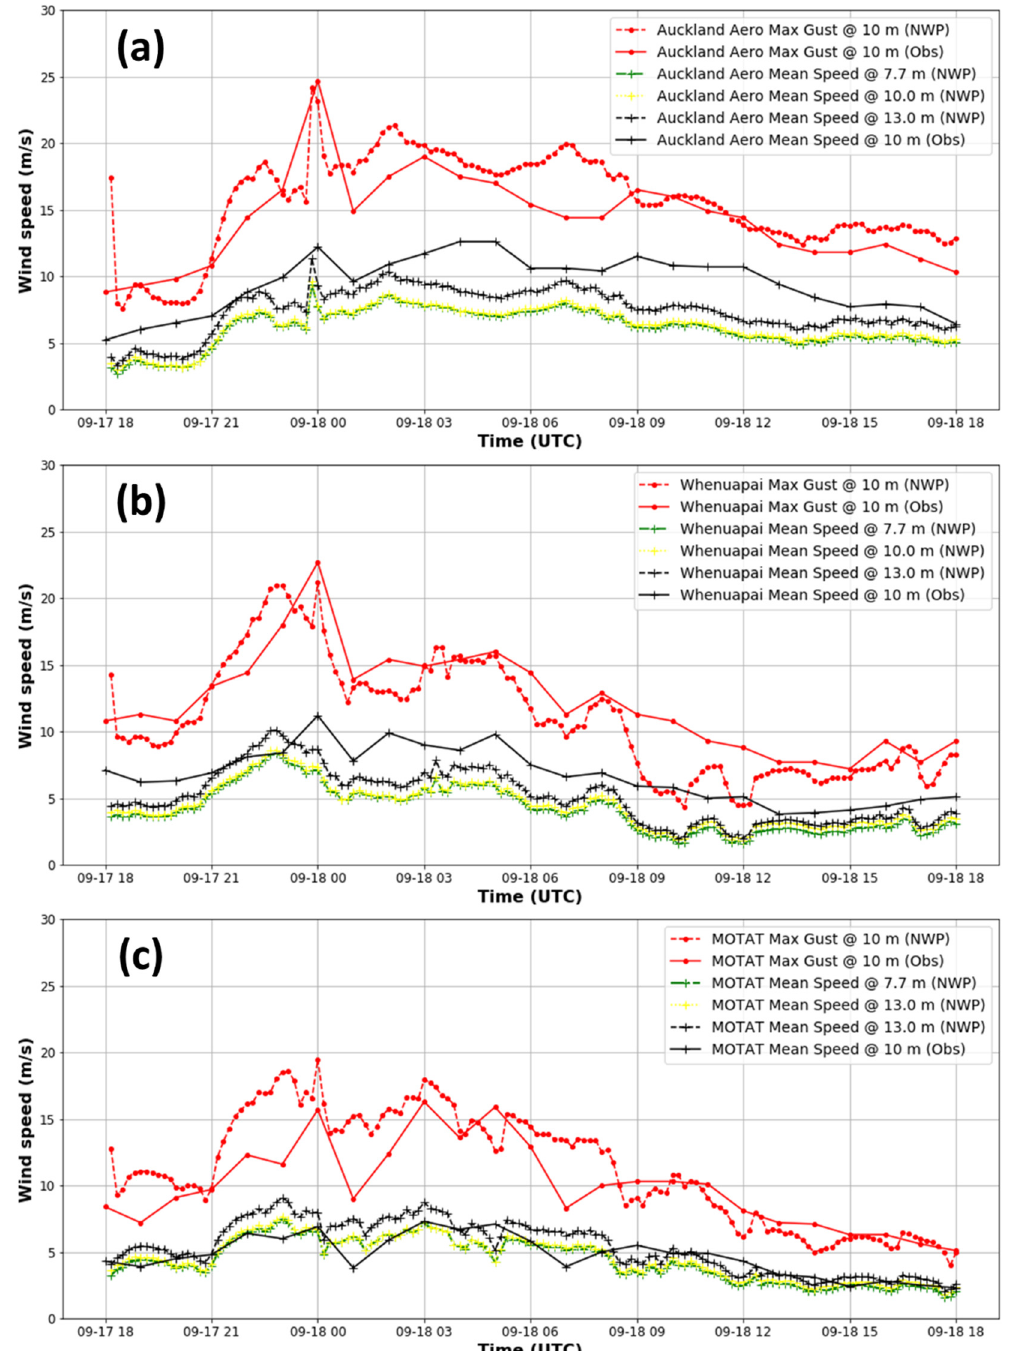
Figure 5. Comparison of gust and mean wind speeds during 17 September 2020 18:00 UTC to 18 September 2020 18:00 UTC from the 333-m NWP model and observations, at: ( a ) Auckland Aero; ( b ) Whenuapai; ( c ) MOTAT.